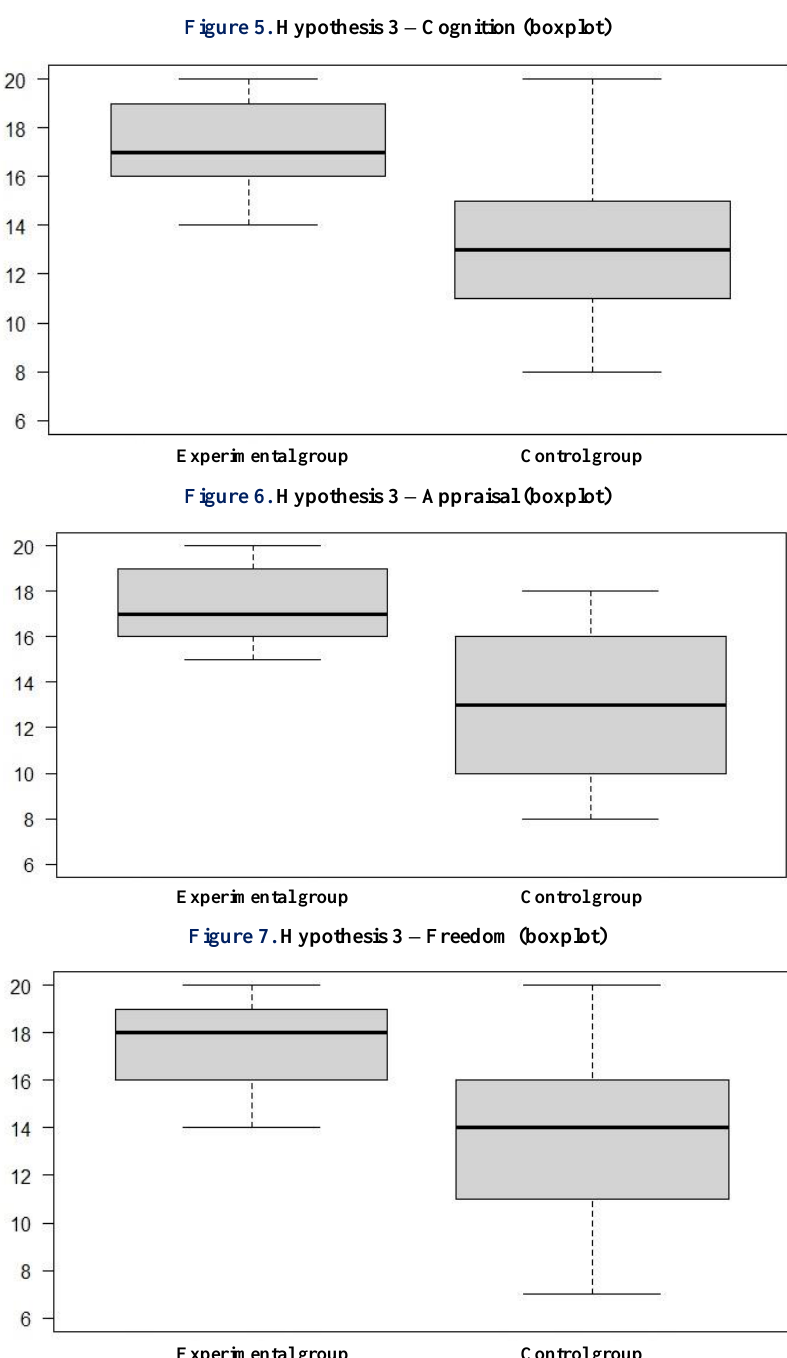
Figure 8. Hypothesis 3 – Success